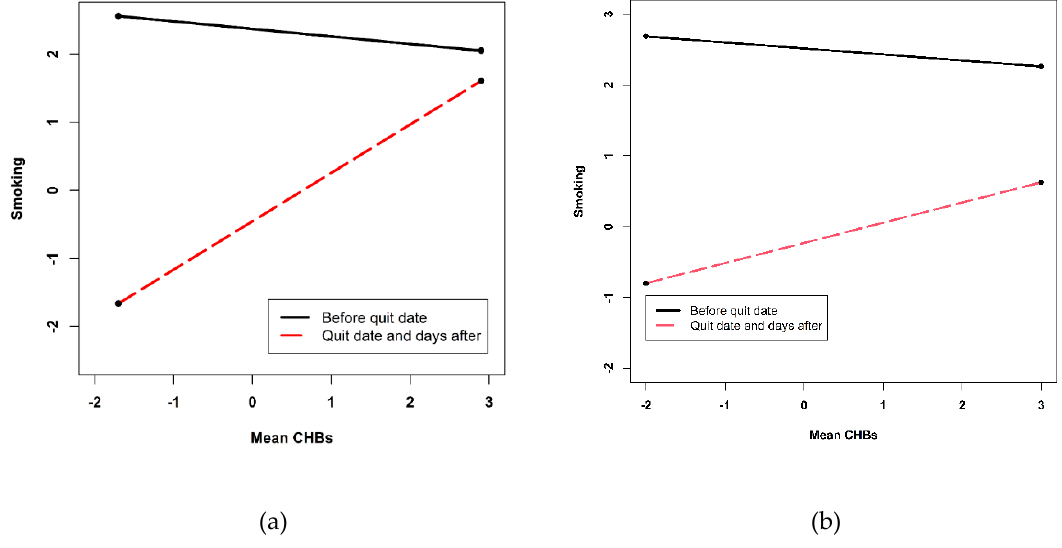
Figure 2. Simple slopes of the between-person variable of daily CHBs (mean CHBs) predicting daily number of cigarettes smoked before and after quit date for women ( a ) and men ( b ). The between-person variable of daily CHBs is centered so that 0 is indicating the mean CHBs value of the average women.